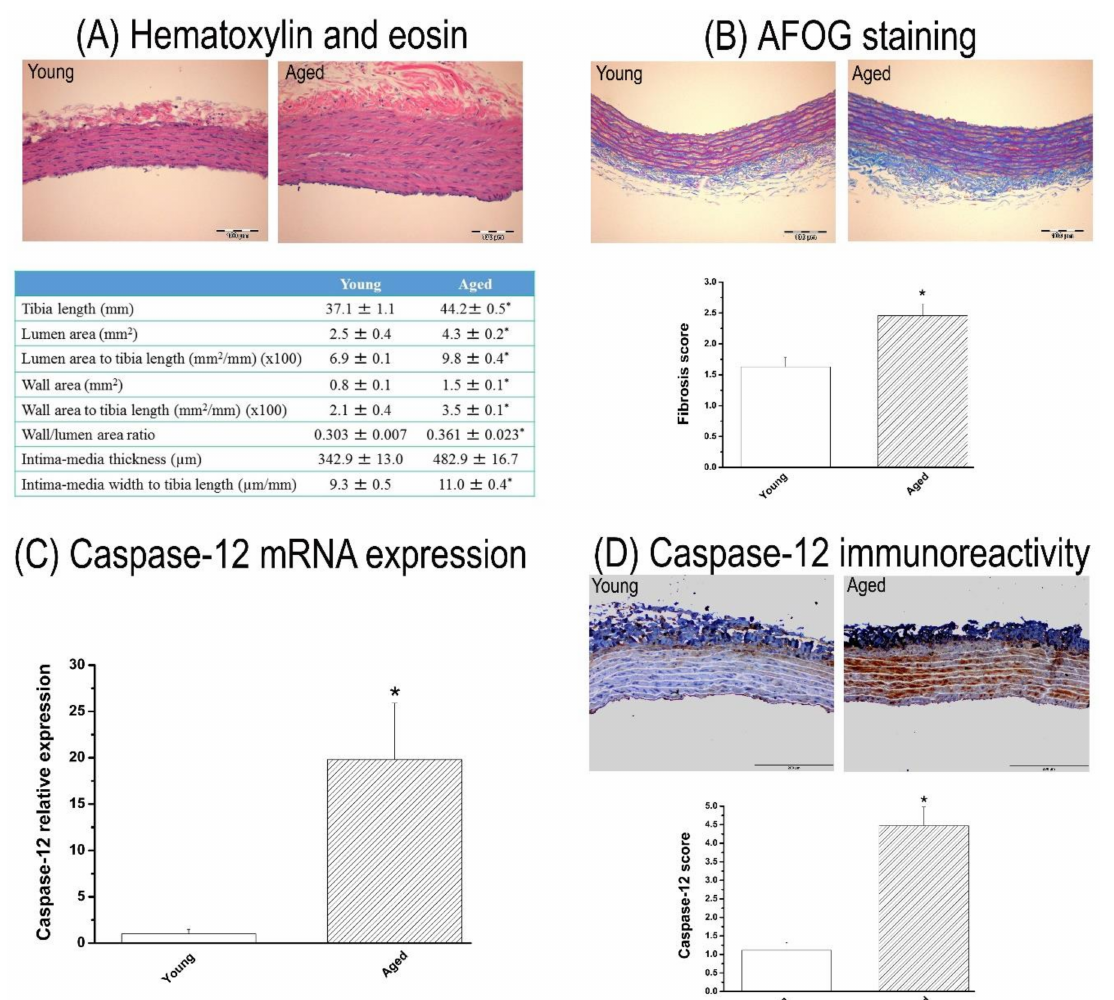
Figure 1. Characterization of the thoracic aorta in 15-month-old rats. Representative image of aortic cross-section stained with ( A ) hematoxylin and eosin followed by the aortic morphometric measurements and ( B ) acid fuchsin orange G (AFOG) staining ( × 20, bar = 100 µ m) followed by semi-quantitative analysis of aortic fibrosis. Caspase-12 ( C ) mRNA expression and ( D ) immunoreactivity ( × 20, bar = 200 µ m) in the aorta. Data are represented as mean ± SEM. * p < 0.05 vs. young. n = 7–8